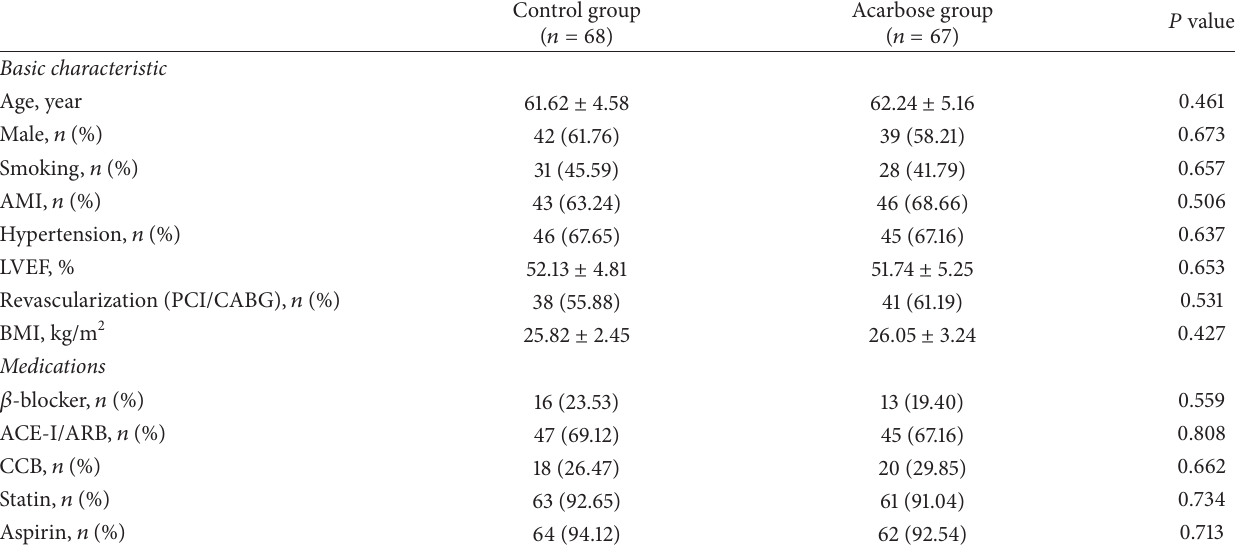
Table 1: Baseline characteristics of study patients and frequencies of medication usage before